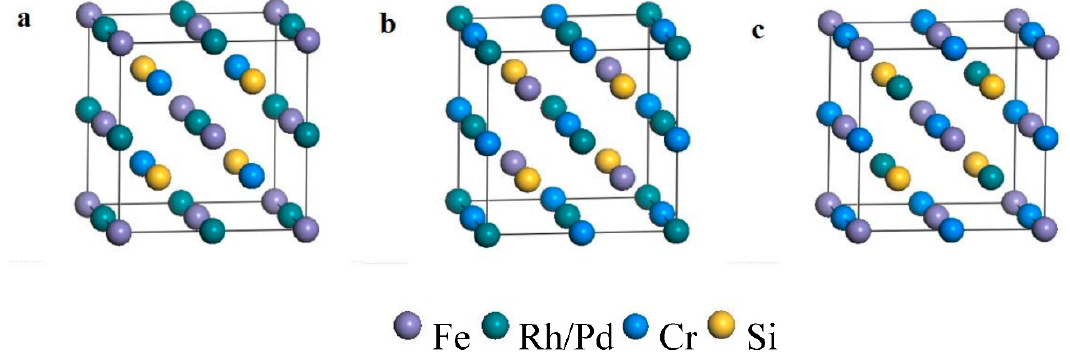
Table 2. The optimized equilibrium lattice constant a 0 (Å), the total and partial magnetic moments ( μ B ) at the equilibrium lattice, the formation energy E f and cohesive energy Ec (eV) for the equiatomic quaternary Heusler (EQH) compounds FeRhCrSi and FePdCrSi.